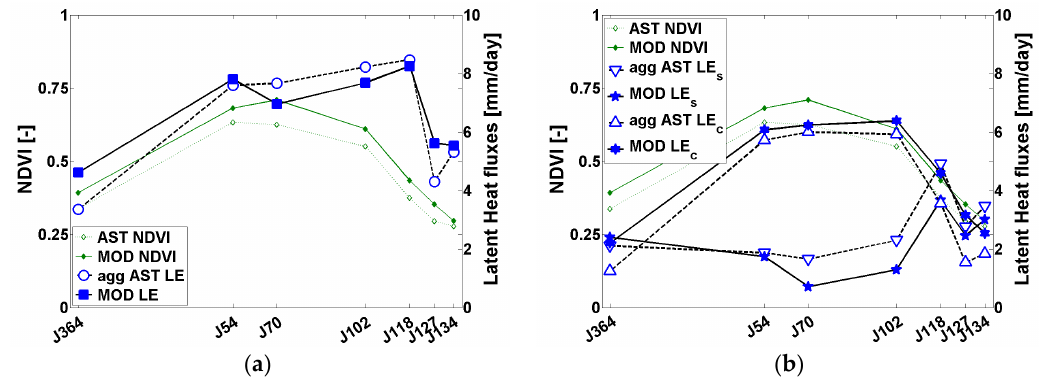
Figure 8. ( a ) ‘agg ASTER’ and MODIS TSEB latent heat fluxes time series; ( b ) partition between evaporation LE s and transpiration LE c .